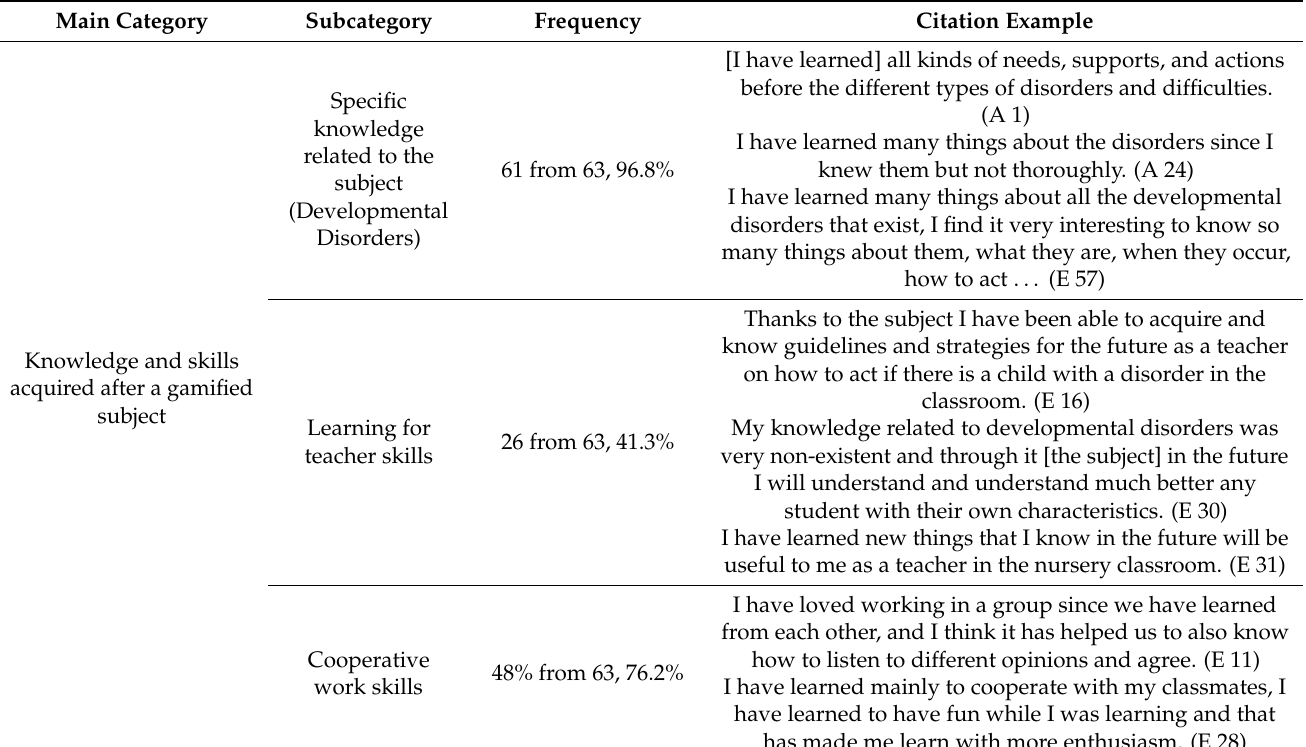
Table 3. Results of main category